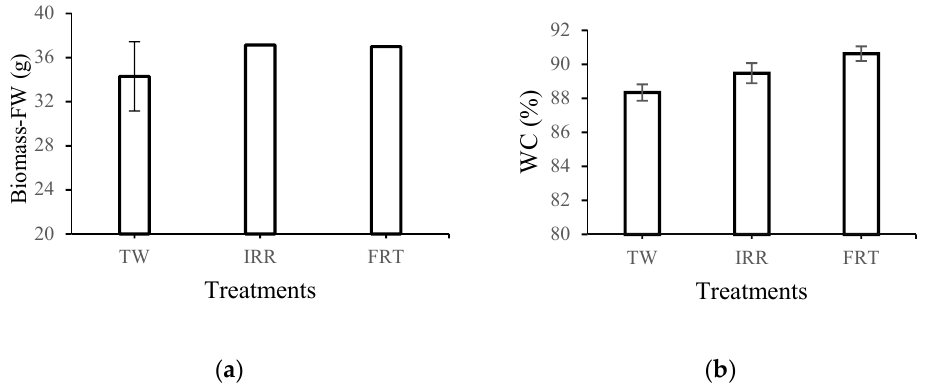
Figure 6. Comparison of the different treatments (TW: tap water; IRR: treated wastewater by NF; FRT: treated wastewater by ED) ( a ) according to the average biomass fresh weight (FW) and ( b ) water content (WC, %) in lettuce leaves. Error bars are reported as standard errors (SEs).